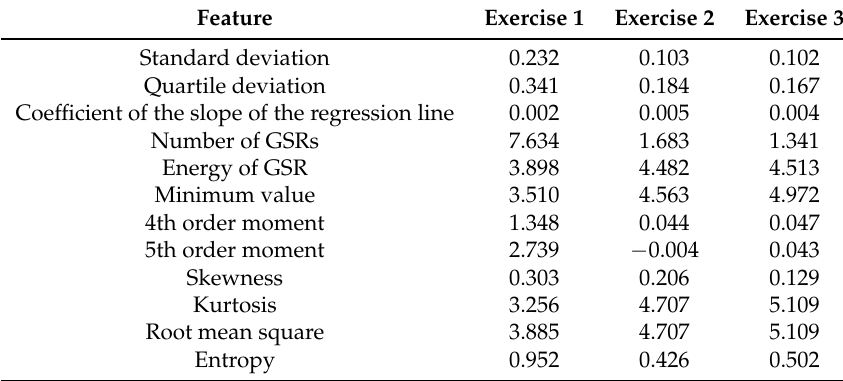
Table 3. Mean values of features during activity (by WCSS).